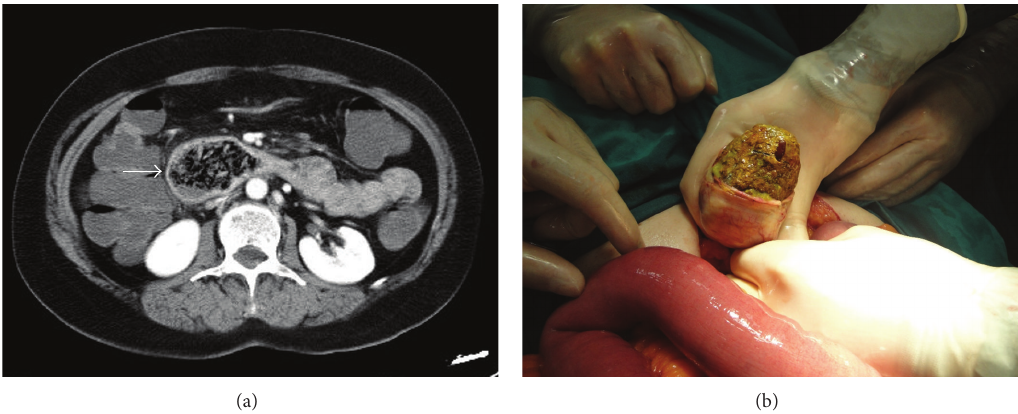
Figure 1: 61-year-old female patient. (a) CT findings: an intraluminal ovoid bezoar. Fusiform-shaped seeds were seen in the mass, and wall thickening was seen in the duodenum (arrow). (b) Intraoperative findings: an ovoid-shaped bezoar containing seeds was removed via